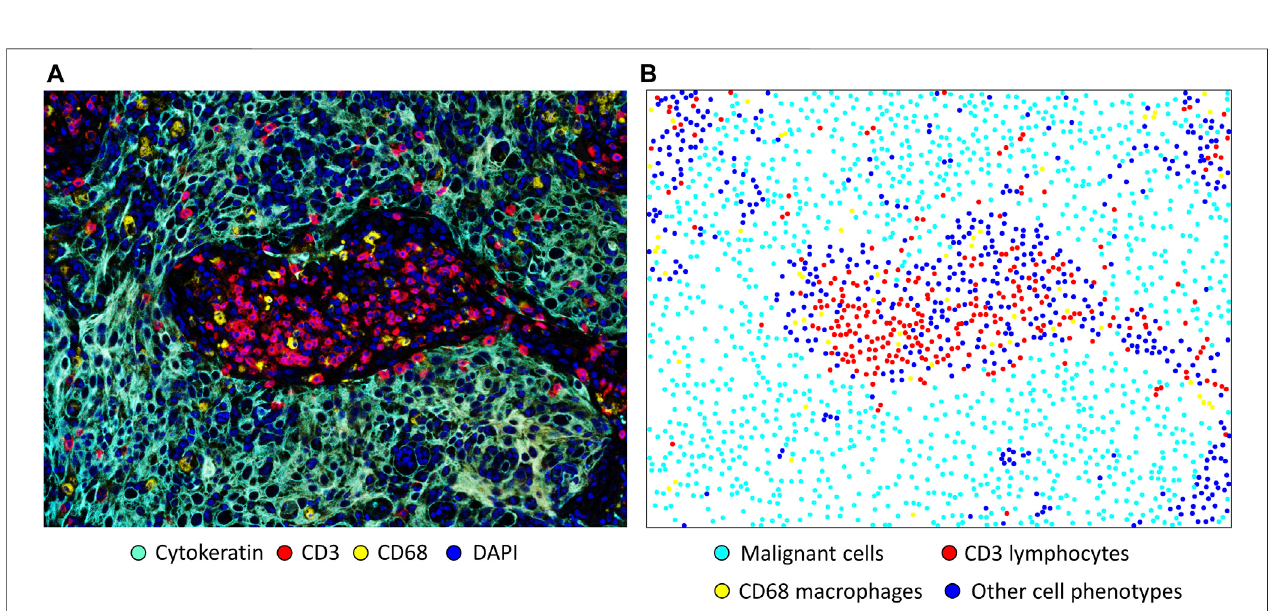
FIGURE 2 | Microphotographs of a representative section of lung squamous cell carcinoma obtained using multiplex immuno fl uorescence staining with a panel containing cytokeratin, CD3 + T-cells, CD68 + macrophages, and DAPI. (A) A region of interest with basic marker staining. (B) Colored dots representing the individual cells shown in A, showing the location of each cell in the image. Original magni fi cation, × 20, from VectraPolaris scanner and processed by Inform software (Akoya Biosciences).